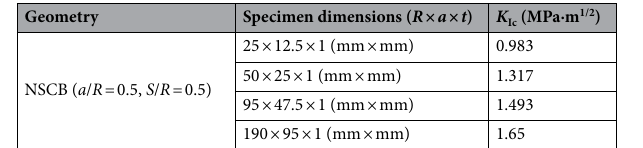
Geometry Specimen dimensions ( R × a × t ) K Ic (MPa·m 1/2 )